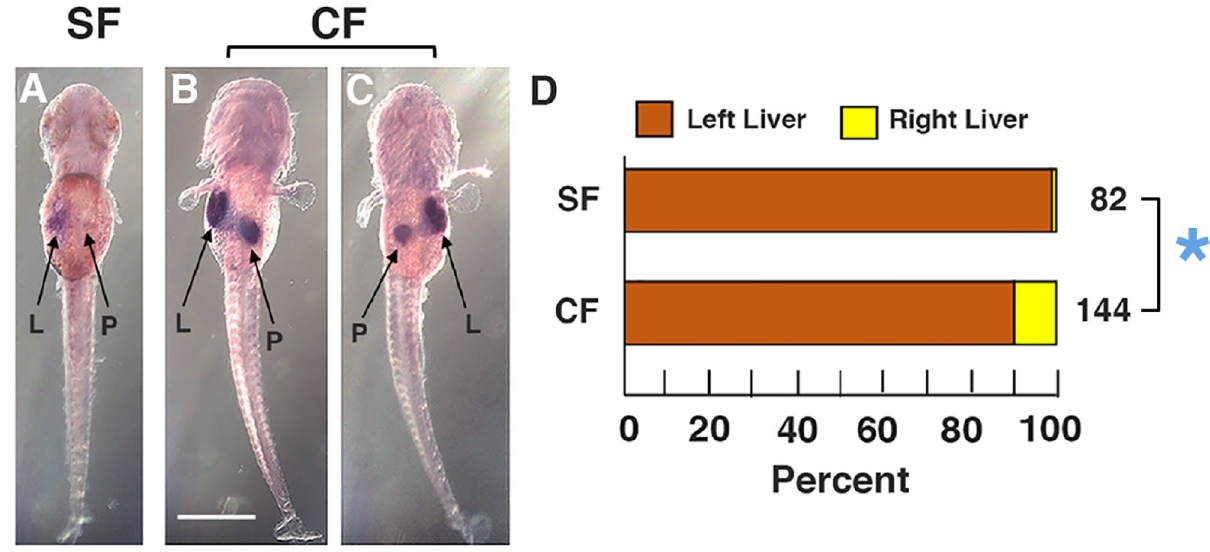
Figure 2. Liver and pancreas laterality in surface fish and cavefish determined by cbsa gene expression. ( A – C ) In situ hybridization showing cbsa expression in liver positioned on the left and pancreas positioned on the right of the midline in surface fish (SF) ( A ), and normal ( B ) and reversed ( C ) liver-pancreas laterality in cavefish (CF) at 3.5 dpf. All views from the dorsal side. L: liver. P: pancreas. Scale bar in B is 500 µm; magnification is the same in all frames. ( D ) Bar graphs showing the percentage of livers positioned on the left or right side in surface fish and cavefish. Total number of in situ hybridized larvae is shown at the right of each bar. Asterisk: Chi 2 statistic = 3.6603, p =